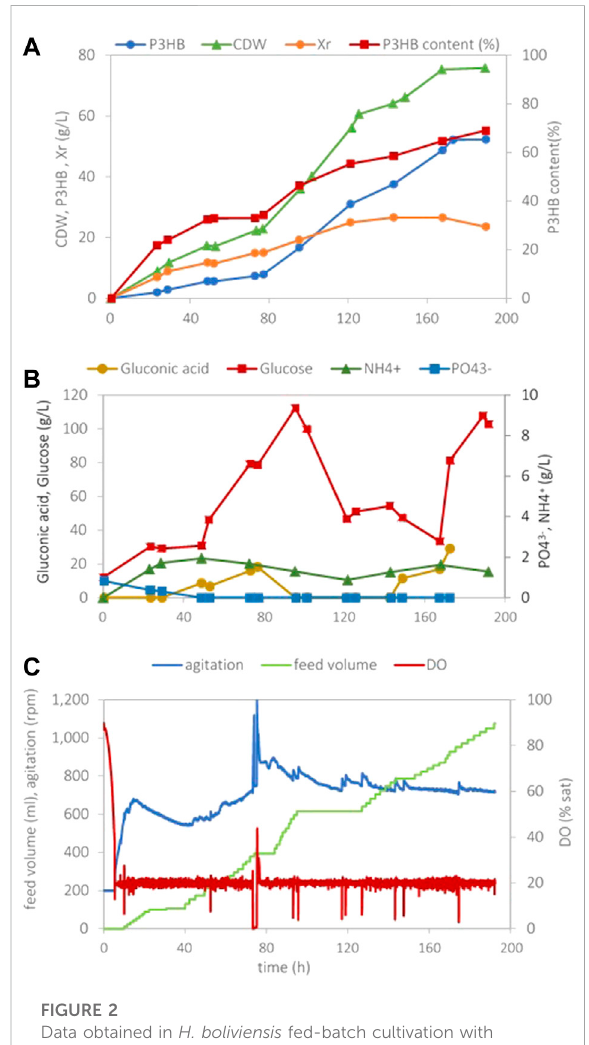
FIGURE 2 Data obtained in H. boliviensis fed-batch cultivation with mineral medium supplemented with 25 g/L of glucose, 1.5 g/L K 2 HPO 4, and7.0 g/LNH 4 ClatpH7.5and20%satofDO.Asolution containing 600 g/L of glucose (1L) was used as feed. (A) Cell dry weight, P3HB, the residual cell concentration, and the P3HB cell content during the cultivation, (B) glucose, gluconic acid, phosphate, and ammonia concentrations, and (C) data acquired automatically during the cultivation.